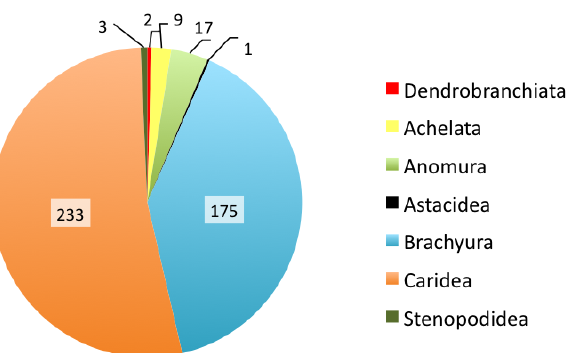
Figure 2. Relative abundance of infraorders of Decapoda registered in the Crustacea collection of INMA.